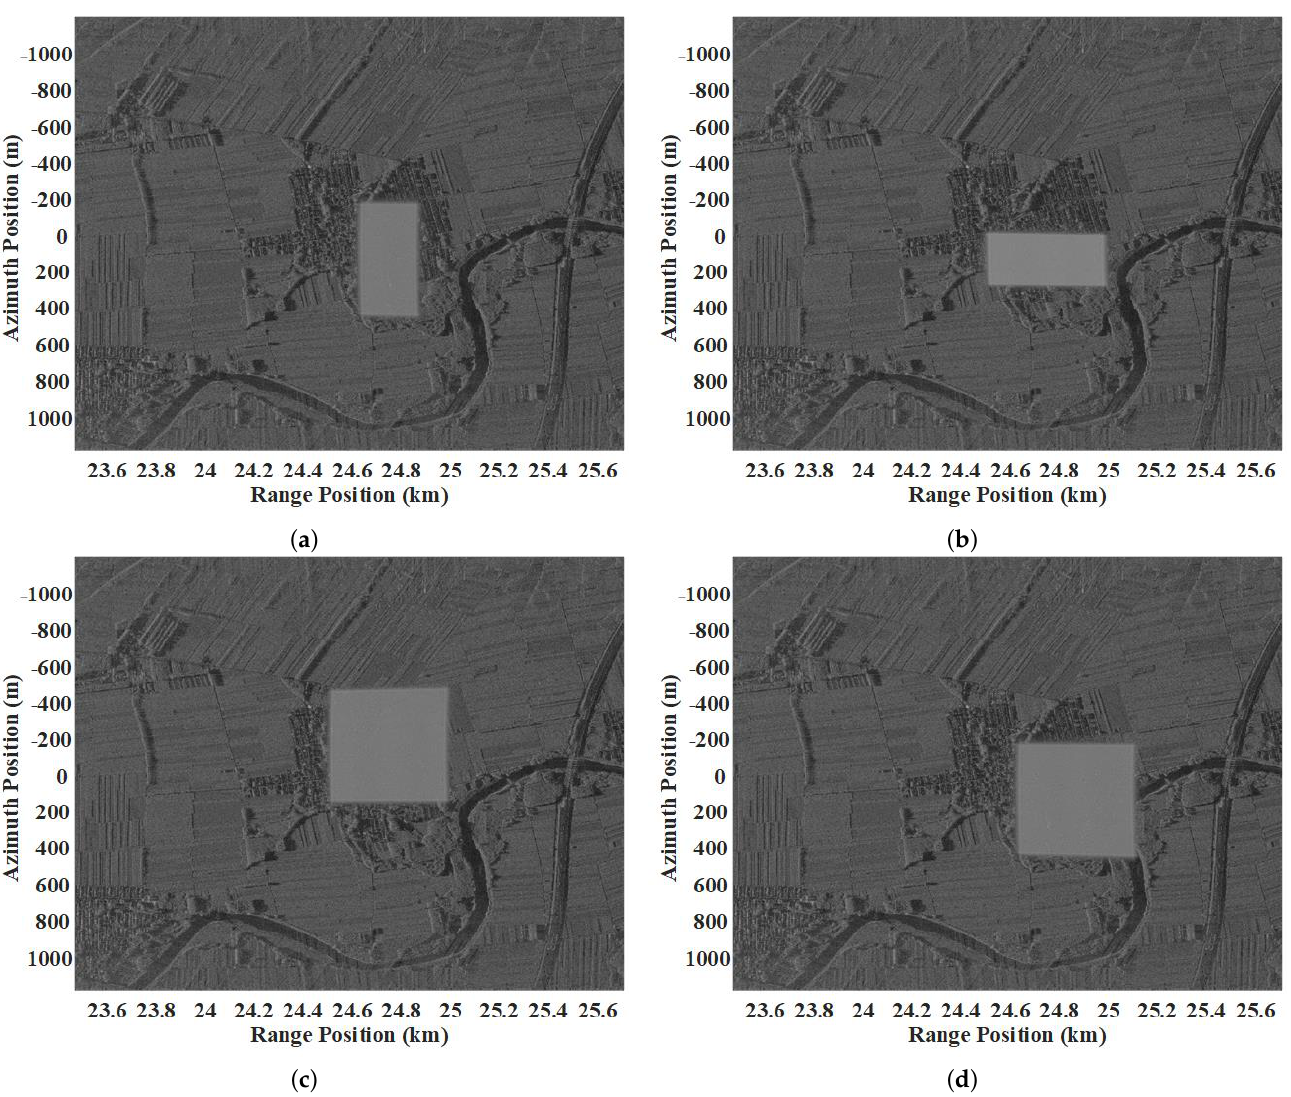
Figure 9. Imaging results of suppression jamming signals under different modulation